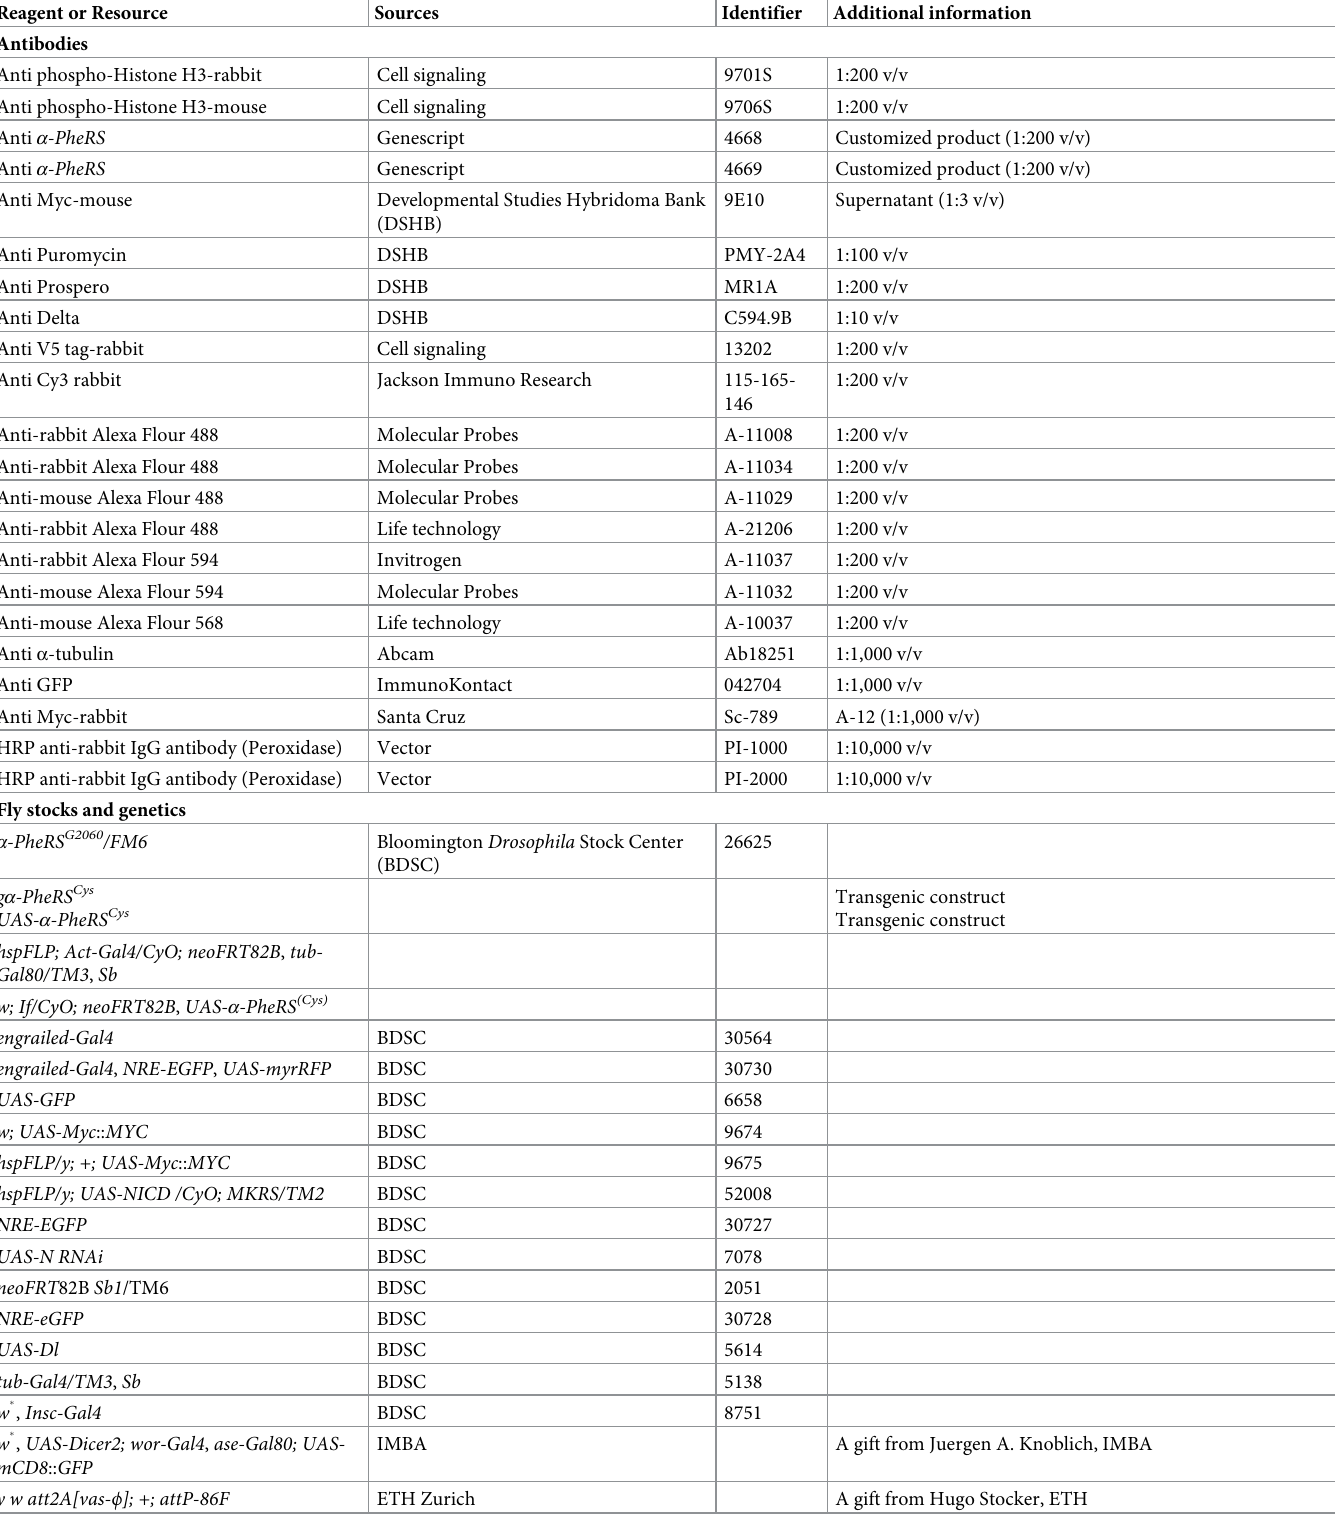
Table 1. Key Resources